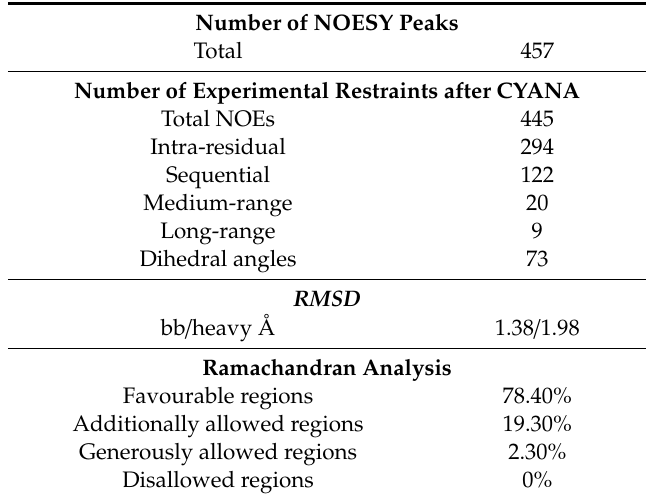
Table 1. Statistics for the structural calculation of the NMR Ensemble of 737-786 gp36 CHR–MPER.